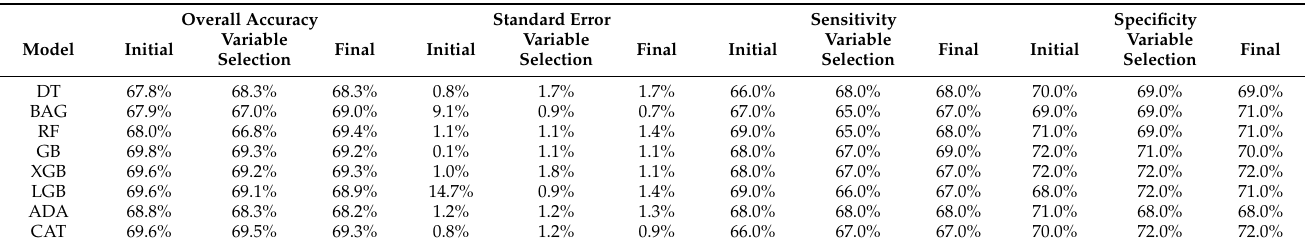
Table 6. Binary model performance metrics between each refinement